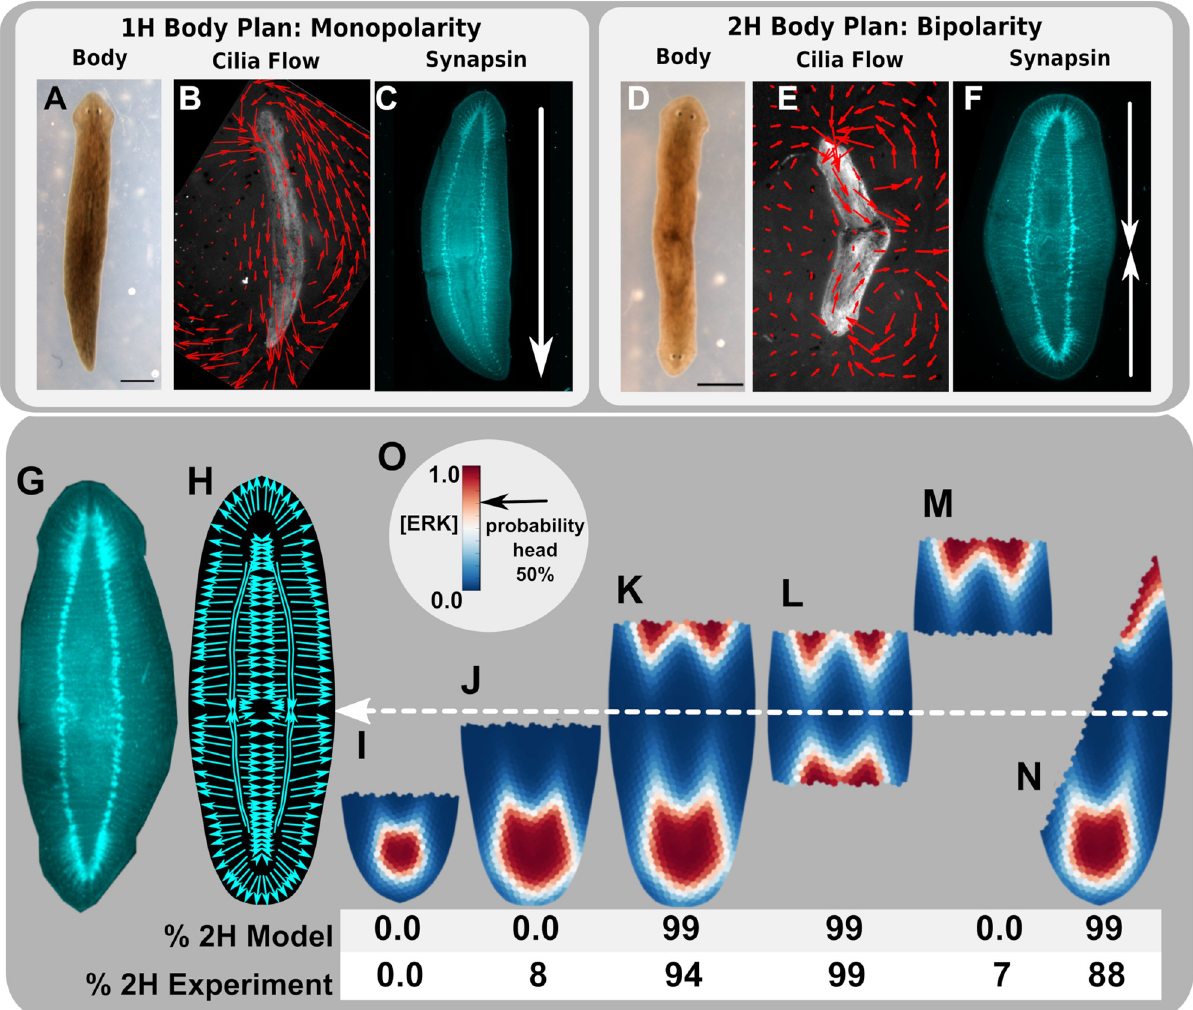
Fig 7. Model-predicted morphogen gradients are consistent with experimentally-observed regeneration outcomes for a variety of cutting scenarios of 2H worms, supporting the vector transport hypothesis. Planaria heteromophoses show organism-level polarities consistent with head number. In 1H worms (A), cilia flow vector fields (B) occur as monopolar gradients with flow directed away from the single head (B, C). In 2H worms (D) bipolar cilia flow fields were observed (E), which exhibit coordinated beat movement away from each of the two heads (F). From the bipolar cilia beat in 2H worms, we hypothesize a bipolar nervous system, where example synapsin stains of a whole 2H worm (F, G) and nerve polarity map trace (H) are shown. The white dotted line shows location of proposed line of symmetry at the midpoint between the two pharnyx for the bipolar 2H transport gradient (H), which is consistent with the observed location of cilia beat flow pattern symmetry in 2H worms. Panels I, J, K, L, M, and N show model-predicted steady-state ERK concentrations, where higher ERK levels are probabilistically associated with head outcomes (as shown in O). Cutting 2H worms showed experimental regeneration outcomes consistent with model predictions for a variety of cutting scenarios (I, J, K, L, M, N). A Chi 2 test was used to compare model and experimental frequencies which showed corroboration between experiment and the model with p <